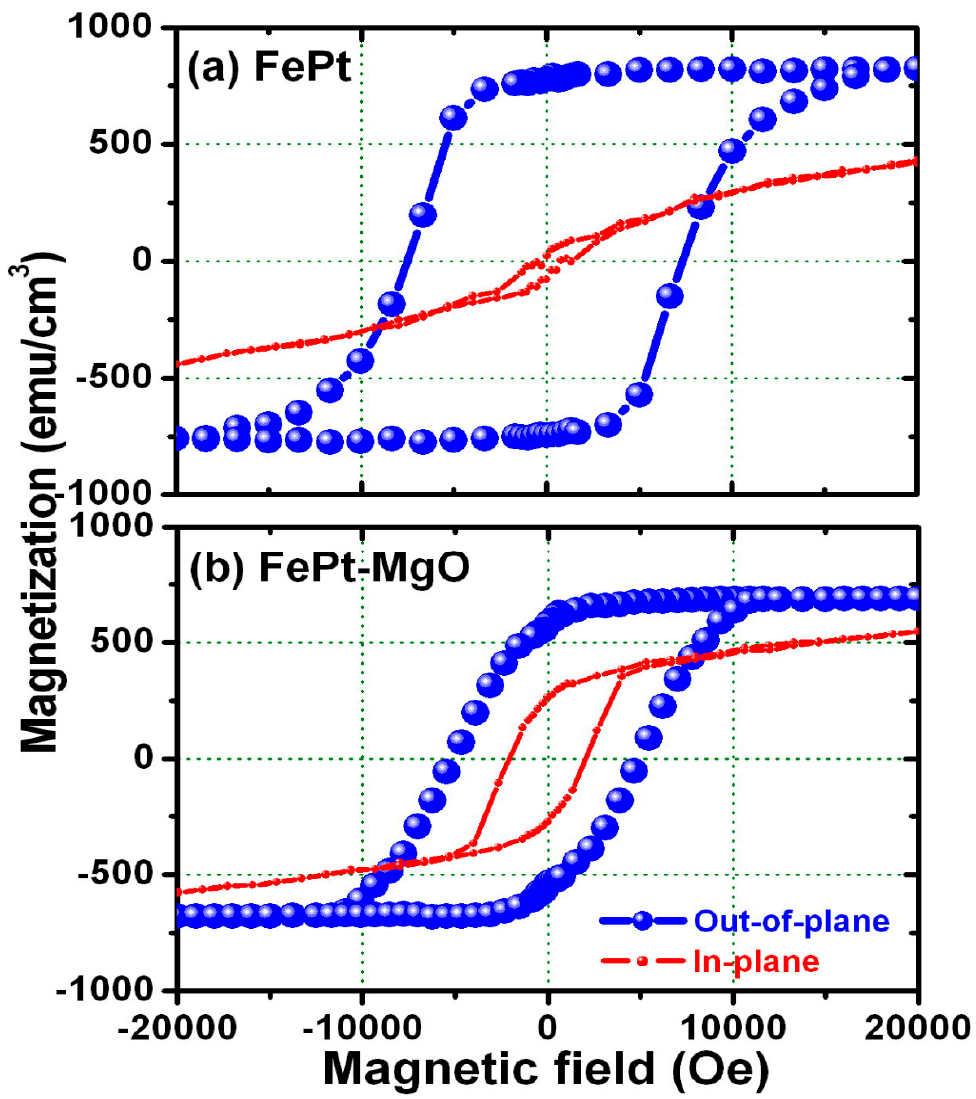
Figure 3. The out-of-plane (blue) and in-plane (red) hysteresis curves for the FePt films ( a ) without and ( b ) with MgO additive nanolayers, respectively. Table 1. FePt films without and with MgO additive layers listed the out-of-plane coercivity ( H c ⊥ ),